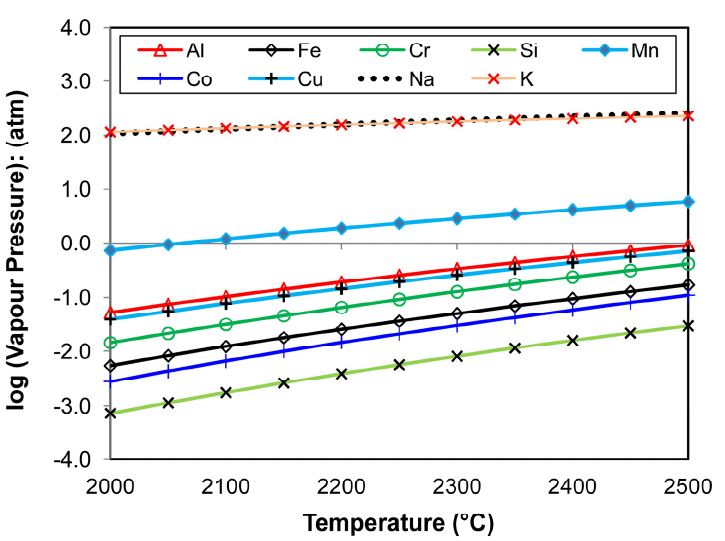
Figure 7. Vapour pressure of pure metals Na, K, Mn, Al, Cr, Fe, Co, Si, Cu vs. temperature. Previous Gibbs free energy calculations confirmed that NaF(g) and KF(g) are most easily formed from reaction of Na 2 O and K 2 O with CaF 2 in reactions of the type displayed in Equation (11) [3,10,11]. The relative position of the lines in Figure 8 indicates that the fluorides of the main elements in the SAW reaction system considered here may all be transformed by reaction with Al(g) to release metal vapour in reactions similar to the re- action in Equation (10). Particularly, copper and cobalt may be transformed in this way, as the lines in Figure 8 for CuF 2 (g), as per Equation (6), and CoF 2 (g), as per Equation (8), have the larger difference from the Al-fluoride formation lines, such as seen in Equation (9).